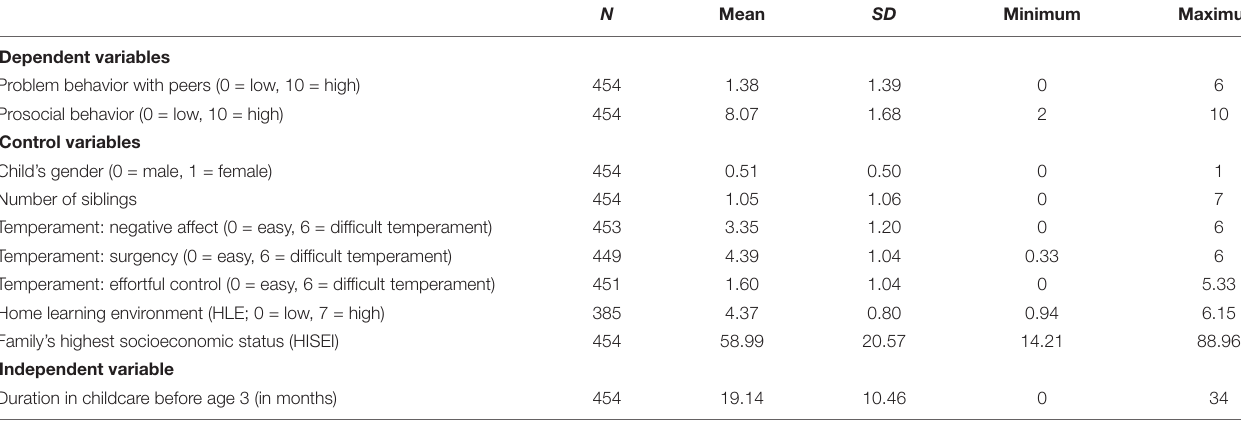
TABLE 1 | Descriptive data on variables in the analyses (children with a migration background).